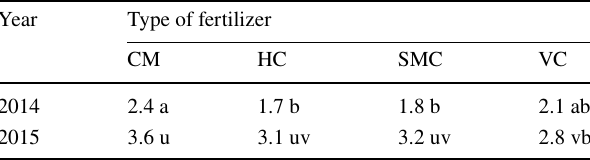
Table 7 Effects of different soil amendments on shoot DM (t ha −1 ) for both years